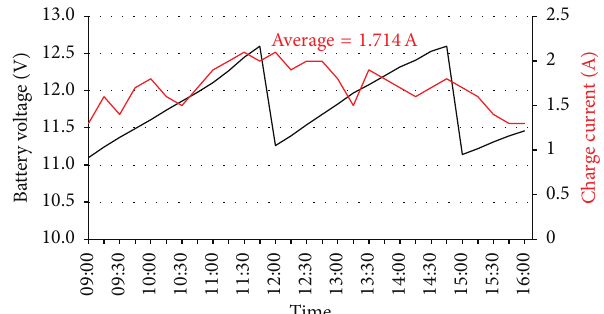
Figure 10: Change in voltage and charge flow values during charge of batteries.